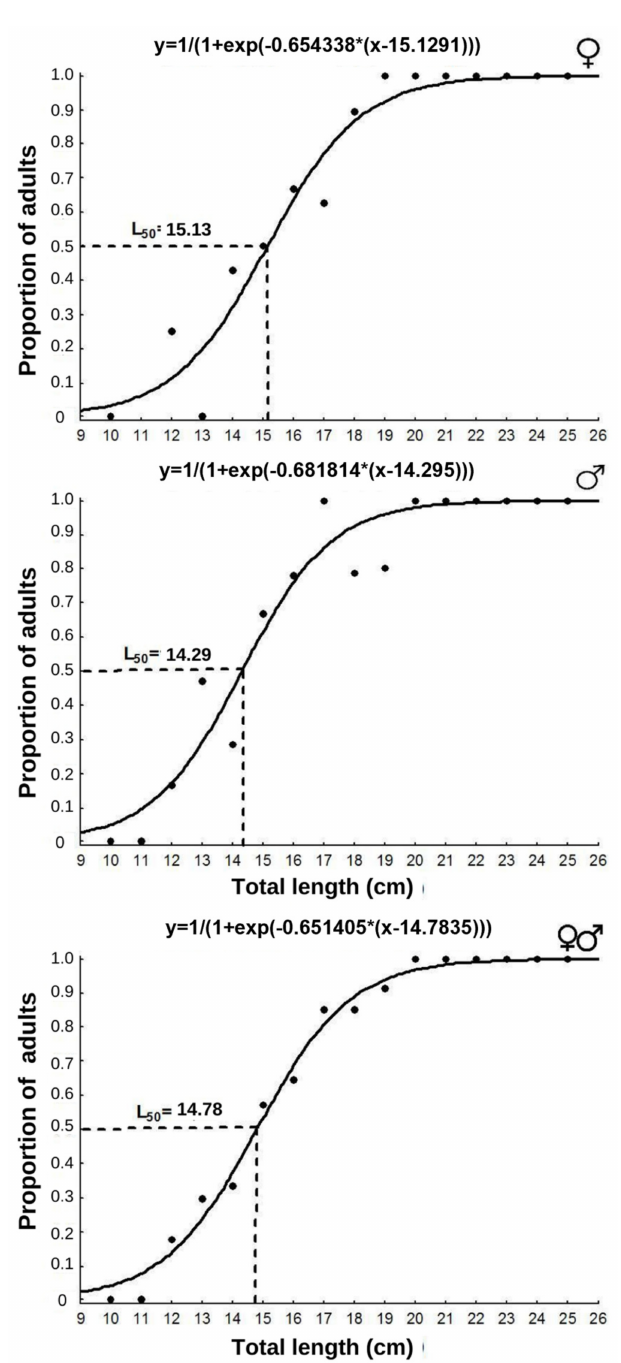
Figure 6. Size of first gonadal maturation of Genyatremus luteus captured from April/16 to April/17, Ajuruteua peninsula, Bragança, PA,